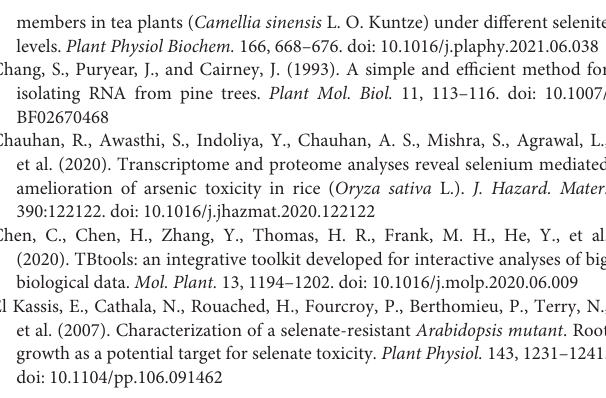
Supplementary Figure 1 | Gene ontology (GO) enrichment analysis of differentially expressed genes (DEGs) in response to selenite and selenate treatment in tea plants. Supplementary Figure 2 | Heatmap of transcriptomic data related to putative selenite and selenate transporters. Different colors indicate different gene expression levels based on log2